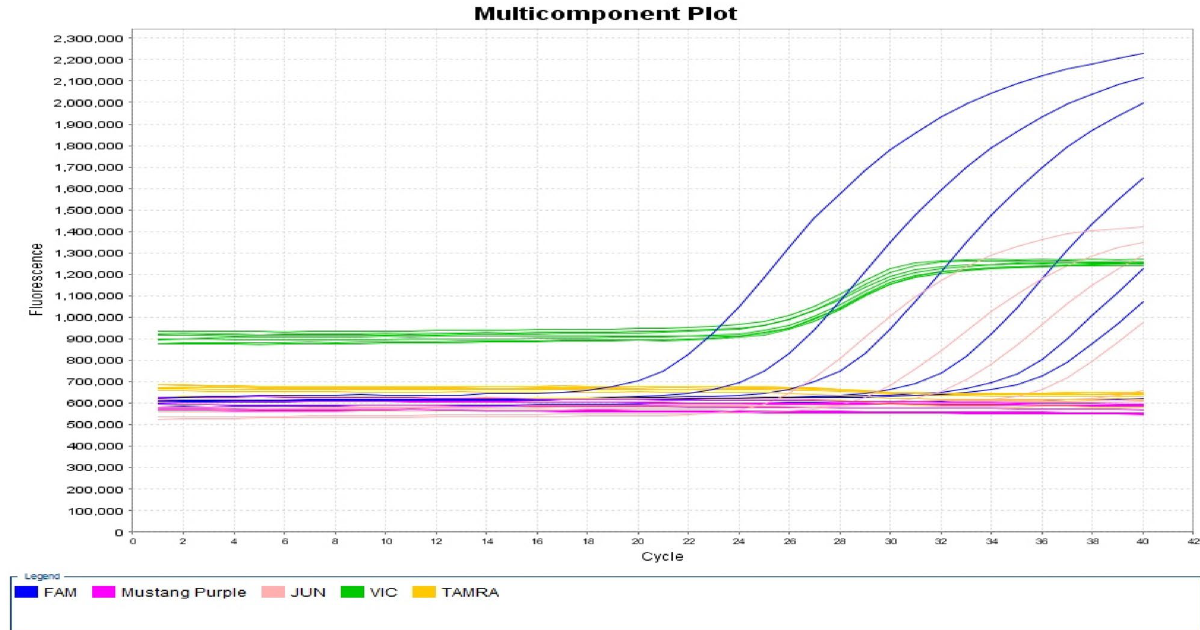
Figure 2. Tenfold serial dilution multiplex amplification of 16S rRNA and PLC of B. cereus 3A The Blue line for the reporter FAM represents 16S rRNA from d0 to d6 corresponding C T values of 21.28, 24.95, 27.99, 31.99, 35.09, 36.23 and undetermined. The Fuchsia line tracks the passive reference dye, Mustang Purple providing an internal reference for normalizing the reporter dye signal during analysis. The Pink line for the reporter JUN represents PLC from d0 to d4 with C T values of 26.29, 29.90, 32.90, 36.98; dilutions 5 and 6 were undetermined. The Green line for the reporter VIC represents the Internal Positive Control amplification used to ensure the quality of the reagents and the instrument. The Yellow line represents the quencher TAMRA. PLC phosphatidylcholine-specific phospholipase